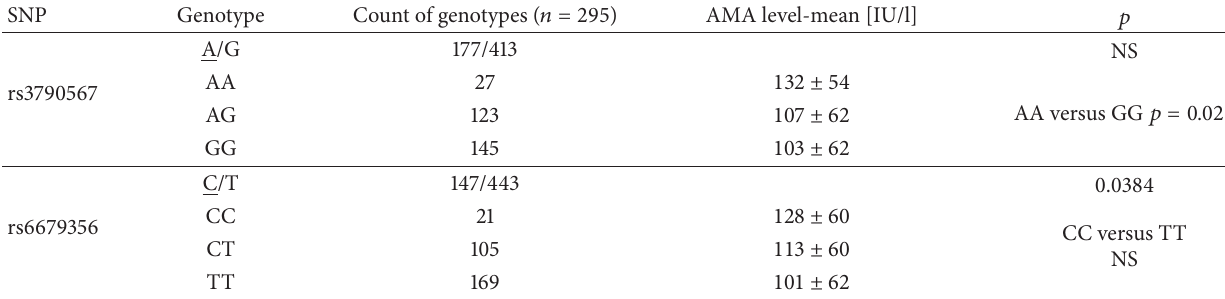
Table 4: The IL12RB2 polymorphisms (rs3790567, rs6679356) association with M2-AMA concentration in patients with PBC. SNP